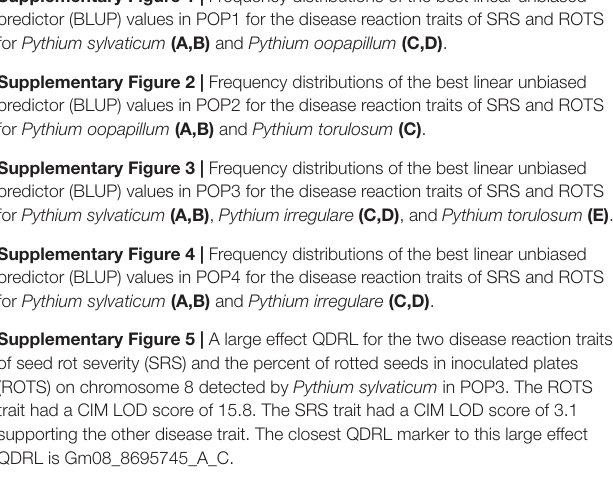
Supplementary Figure 7 | A large effect QDRL on chromosome 8 for the disease reaction trait of seed rot severity (SRS) with a CIM LOD score of 63.2